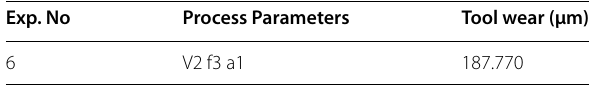
Table 6 Optimum process parameters Exp. No